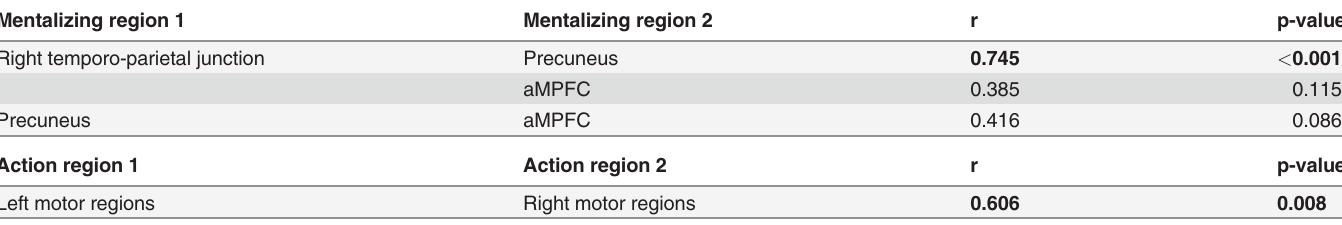
Table 4. Correlations within sets of co-activated regions.